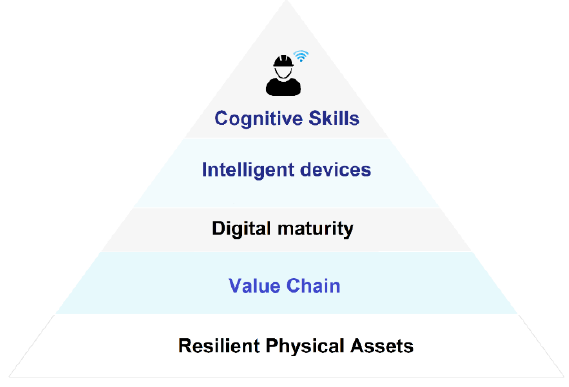
Figure 7. Worker 5.0 pyramid.